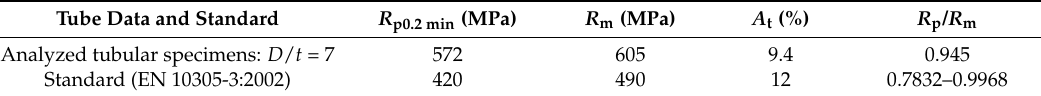
Table 1. Mechanical properties of the analyzed material E420 + CR2